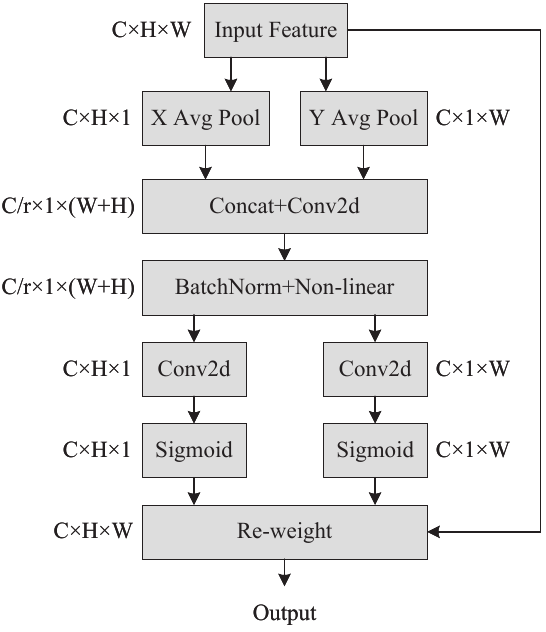
Figure 4. Coordinate attention generation